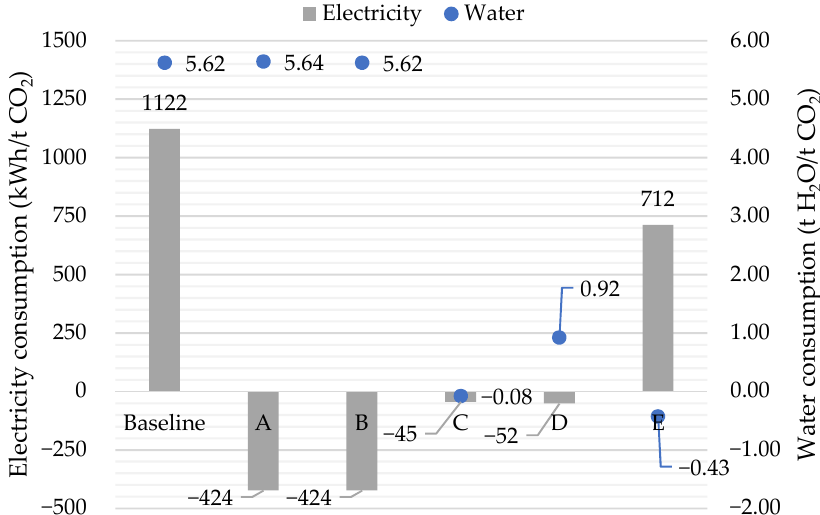
Figure 11. Global electricity and water consumption or production of each scenario.